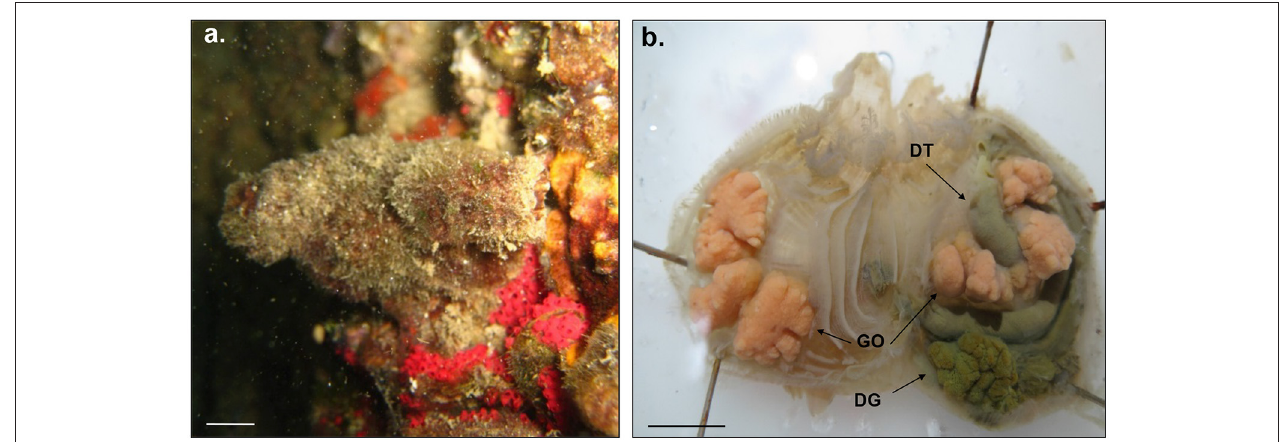
FIGURE 1 | (A) Microcosmus exasperatus . Note the heavy epibiont cover on its tunic (B) A dissected specimen. The left gonad is partially enveloped by the gut; (GO) gonads, (DG) digestive gland, and (DT) digestive tract. Scale bars =